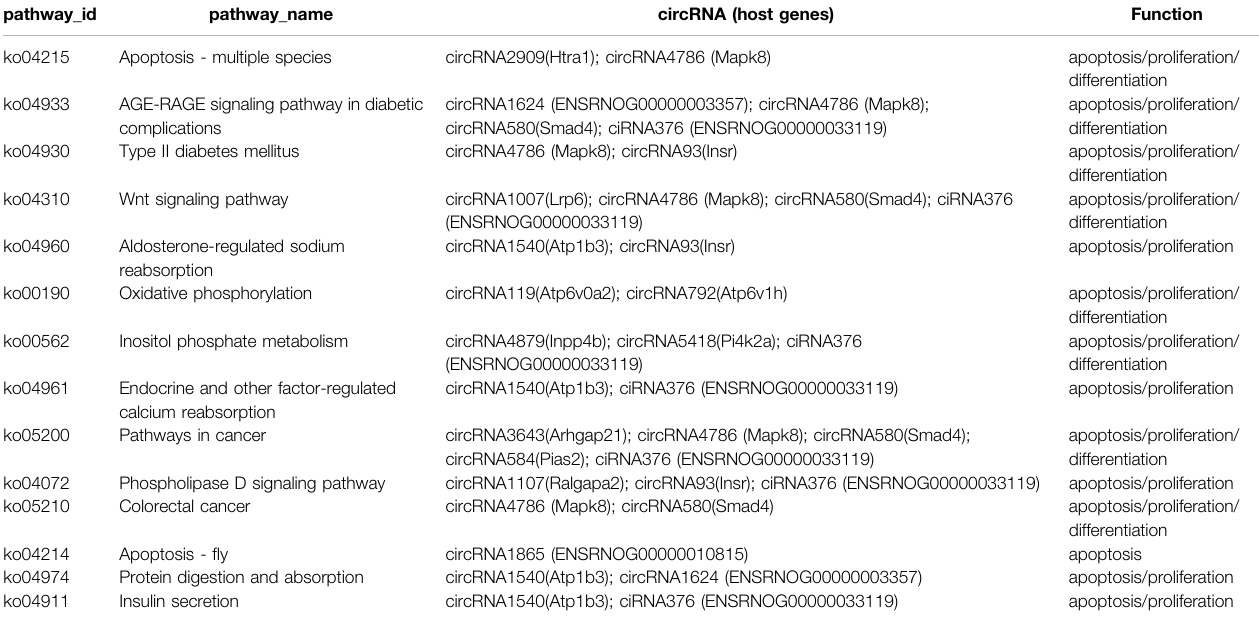
TABLE 4 | KEGG enrichment of DEcircRNAs related to adipose tissue aging (apoptosis, proliferation and